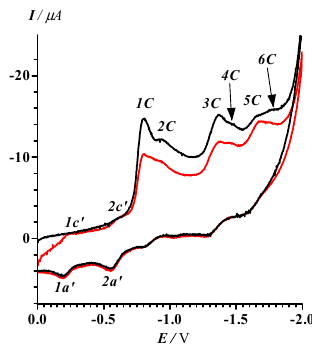
Figure 2. CV of 13 in MeCN (black curve: first cycle; red curve: second cycle). The potential sweep range was 0 > E > − 2.0 V and the potential sweep rate 100 mV·s –1 . Peak potentials ( − E ij p [30], V): 1C, 0.80; 2C, 0.93; 3C, 1.37; 4C, 1.47; 5C, 1.68, 6C, 1.76; 1c’, 0.24; 1a’, 0.19; 2c’, 0.62; 2a’, 0.56.